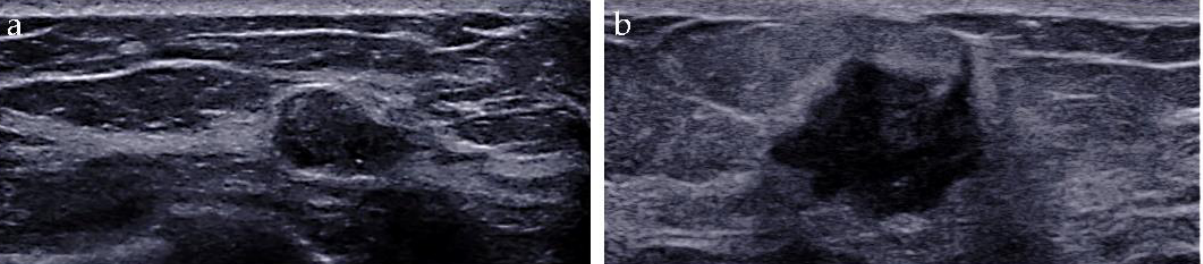
Figure 2. Conventional ultrasound evaluation of breast lesions. ( a ) An irregular-shaped, circum- scribed, hypoechoic mass with depth-width ratio < 1, with microcalcifications, absent halo, and no posterior acoustic features. US-guided core needle biopsy revealed this lesion to be an adeno- myoepithelioma. ( b ) An irregular-shaped, non-circumscribed, hypoechoic mass with depth-width ratio < 1, with no microcalcifications, presence of halo, and posterior acoustic enhancement features. Surgical pathology revealed this lesion to be an invasive ductal carcinoma.